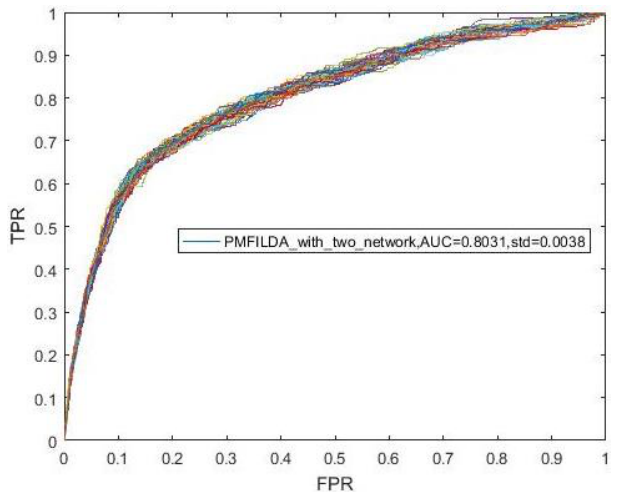
Figure 7. ROC curves and AUCs achieved by PMFILDA based on two association